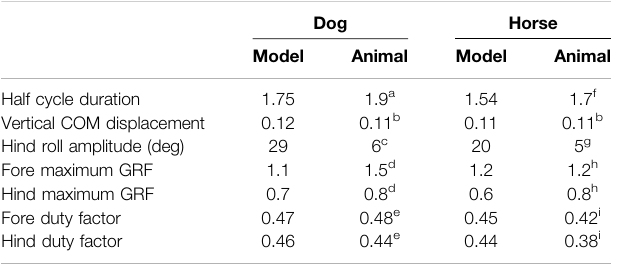
Table 2 . The locomotion characteristics of the simulation results of the horse model are also consistent with those of the measured data except for the roll amplitude of the hind body.